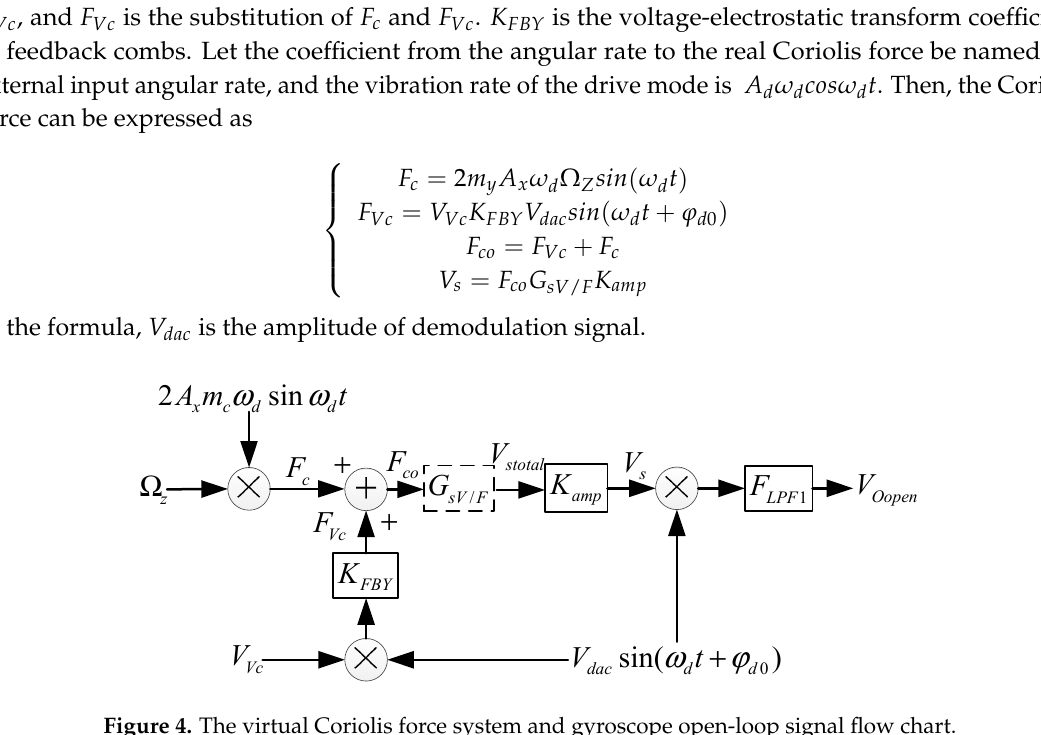
Figure 4. The virtual Coriolis force system and gyroscope open-loop signal flow chart.